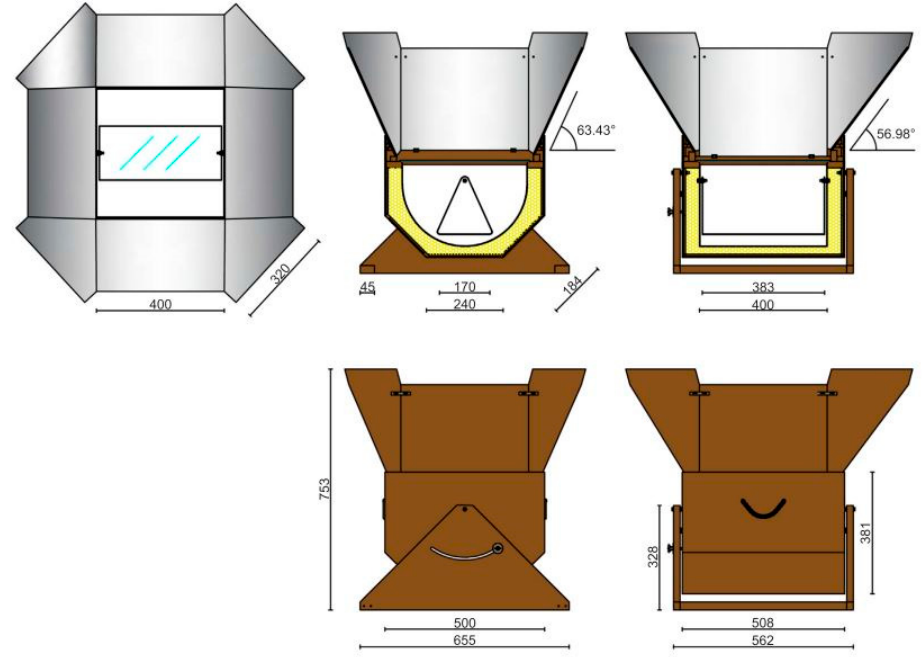
Figure 21. Cross-sectional view of the portable solar box cooker. Reprinted/adapted with permission from Ref. [64], 2020,